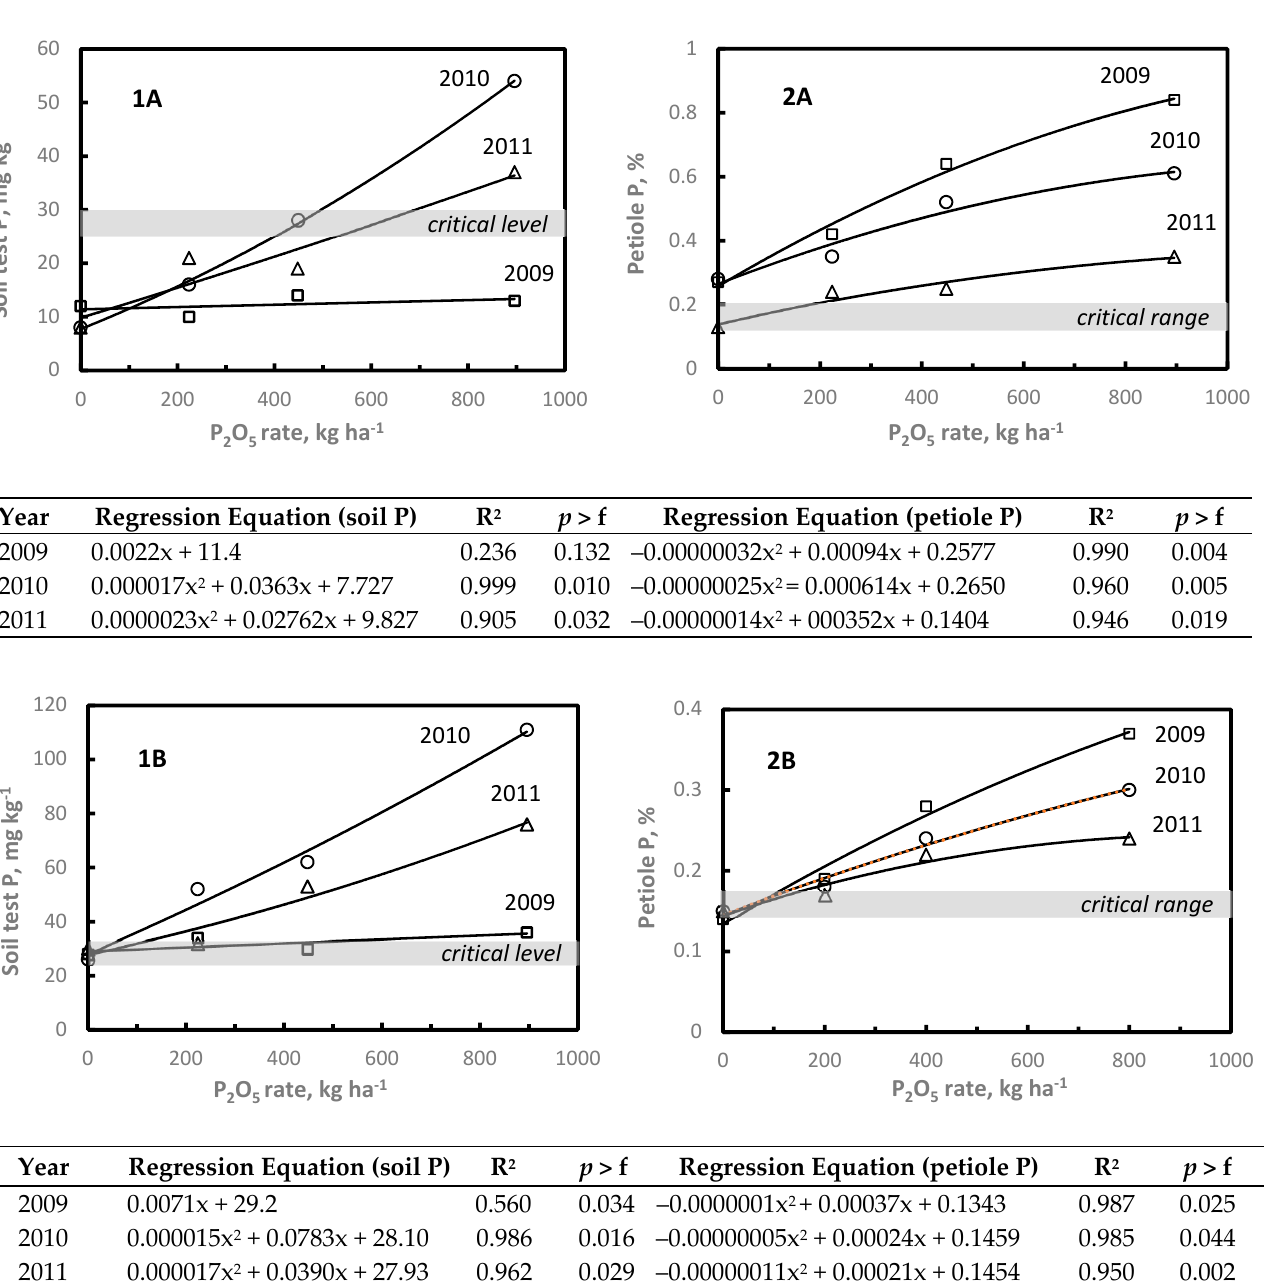
Figure 2. Influence of soil applied P 2 O 5 on soil test P (1) and petiole P (2) content at 1P09 (A) and 2P09 (B) sites. Critical soil test level and critical nutrient range are displayed (shaded bar). Symbols for each year represent treatment means.